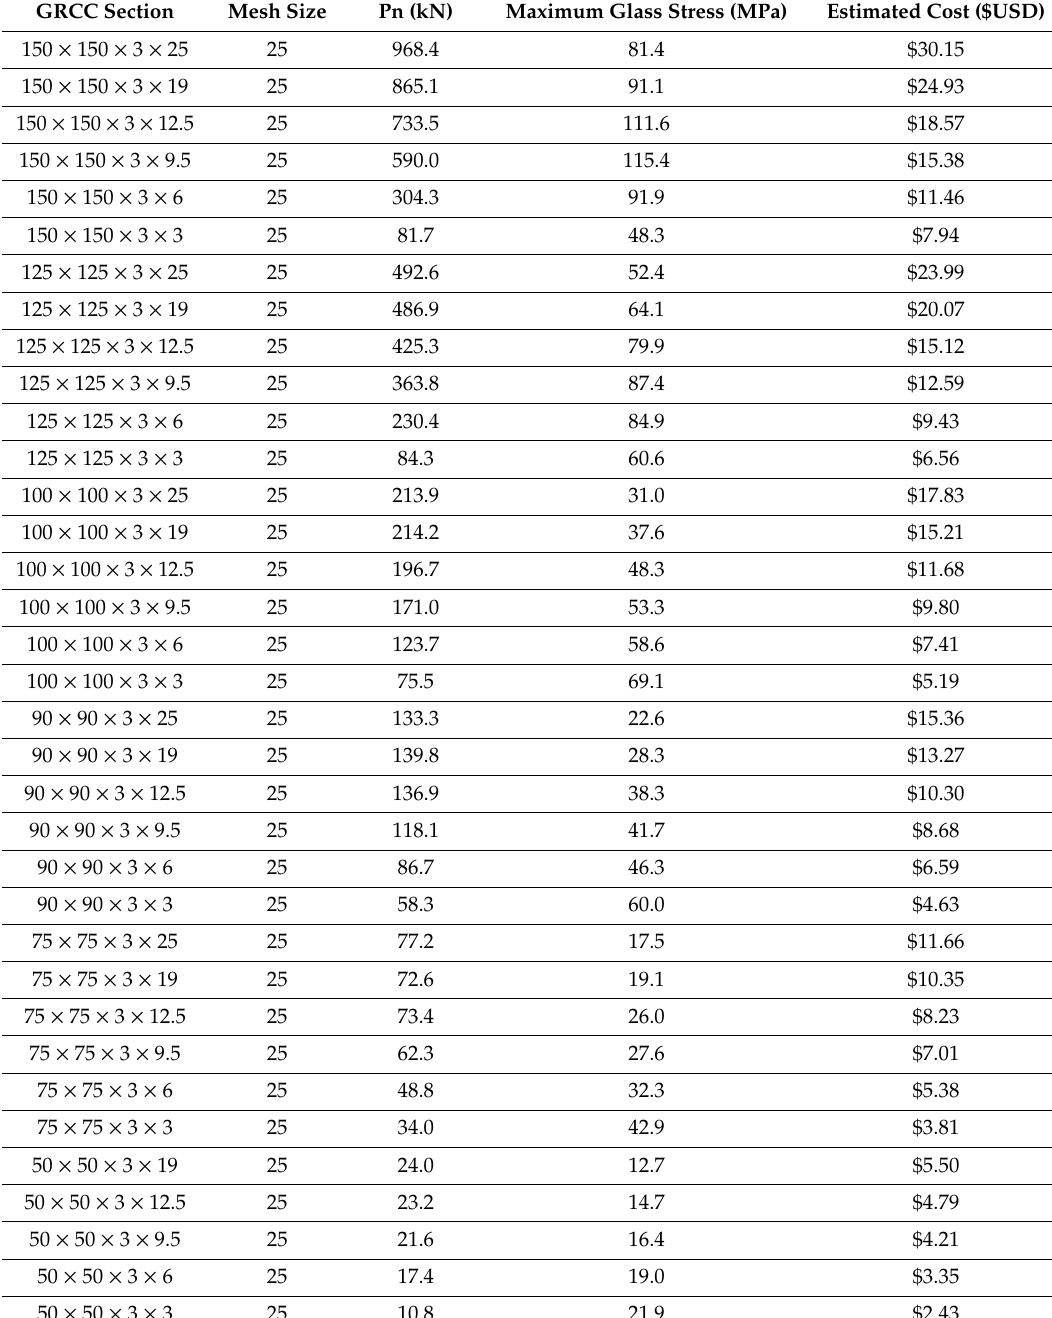
Table 4. The mesh sizes, buckling loads, maximum glass stresses, and estimated costs are presented for the finite element modeling (FEM) GRCCs. Note that the designation is OD × OD × ES × GP (see Figure 11 for references to the